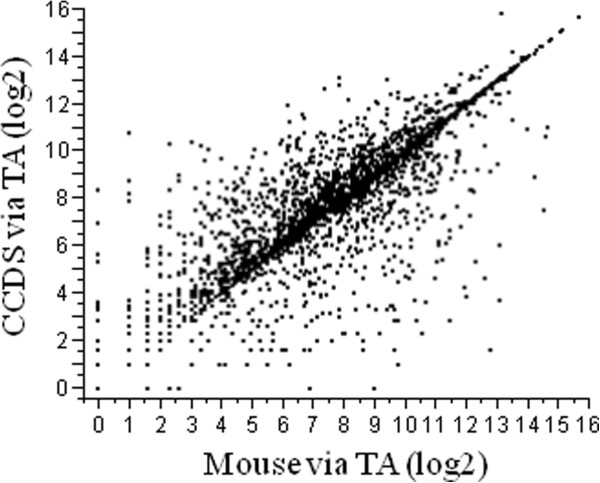
Quantiative gene expression results comparing results from direct mapping vs. using a Mouse proxy. Comparison of expression levels (log2) between genes identified via BLASTn of TA contigs and the H. sapiens CCDS dataset (Y-axis), and genes identified first via BLASTx of TA contigs and the Mouse dataset, and then BLASTp RBH of Mouse dataset and the Human dataset (X-axis). Each point represents a CCDS gene. Points above line of unity include genes that lose contigs through no hit in the Mouse dataset.